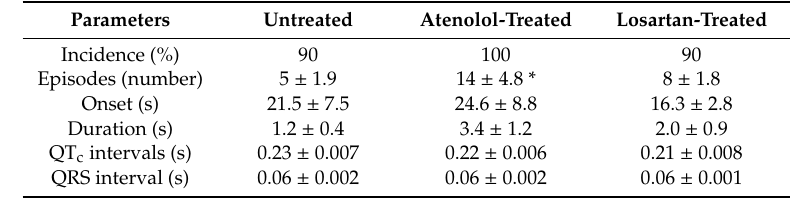
Table 2. Incidence, episodes, onset and duration of arrhythmias due to epinephrine (32 µ g / kg) in rats treated with and without a beta-adrenoceptor blocker atenolol (20 mg / kg / day) or an angiotensin receptor blocker, losartan (20 mg / kg / day) treatment for 15 days.